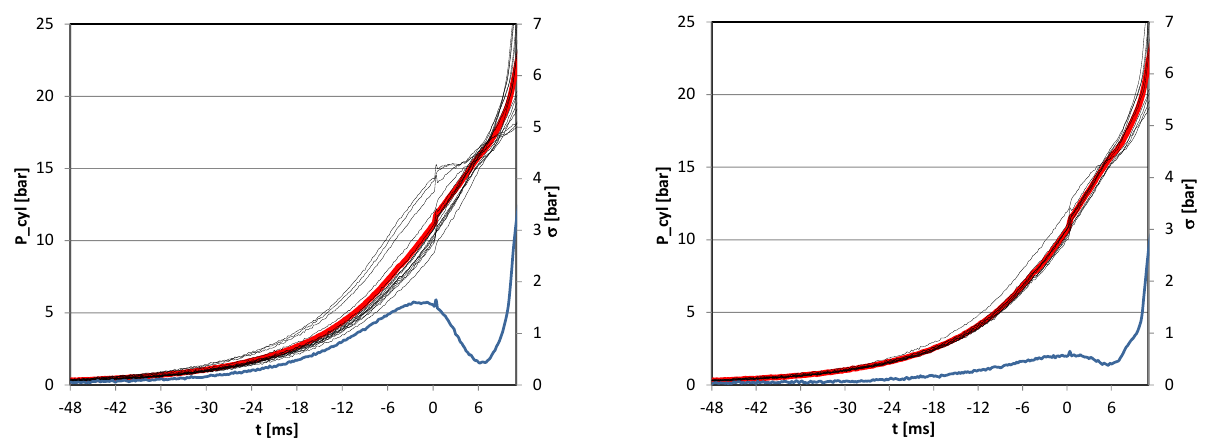
Fig. 3. Sequences of indicated pressure P_cyl (black), mean value (red) and standard deviation (blue) for the compression curve using conventional igni- tion. On the left before the selection, on the right after the exclusion of incorrect RCM work cycles; the characteristic peak on the pressure curve was caused by interferences from the ignition system (t = 0